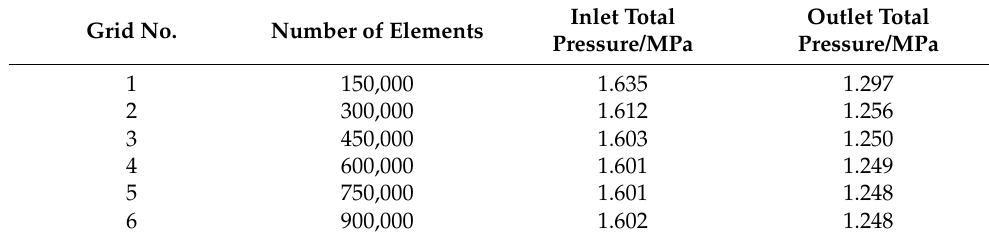
Table 2. Grid independence verification.